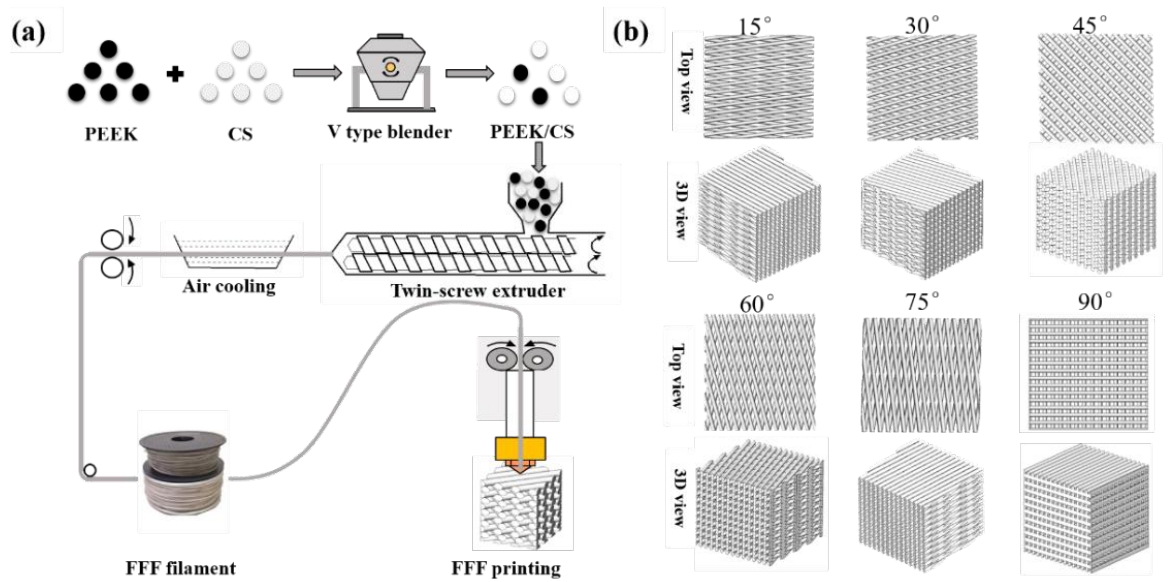
Figure 1. (a) PEEK/CS scaffolds fabricating process; (b) the schematic diagram of the scaffolds with different raster angle. Figure 1. ( a ) PEEK/CS scaffolds fabricating process; ( b ) the schematic diagram of the scaffolds with different raster